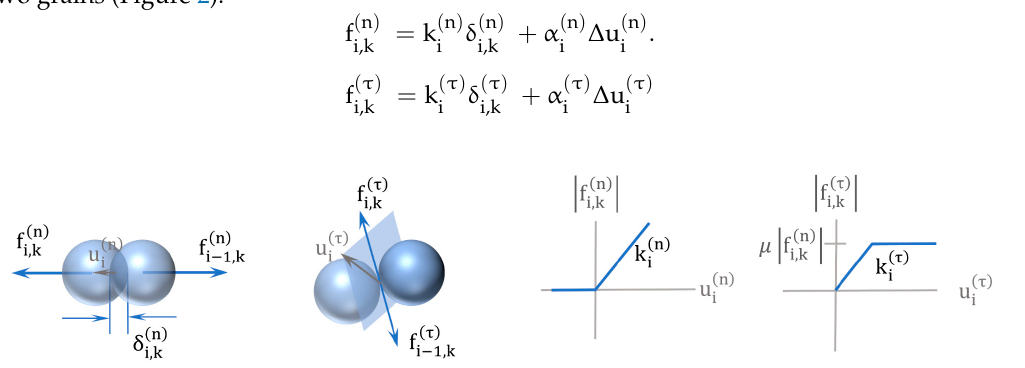
Figure 2. Contact forces revised from Fleischmann [29].